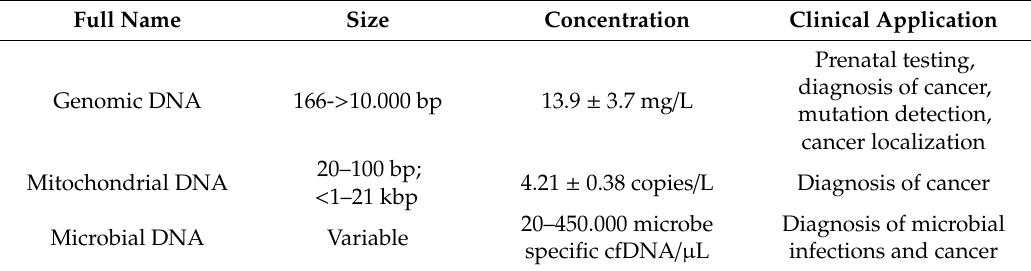
Table 2. Cell-free DNA in serum /